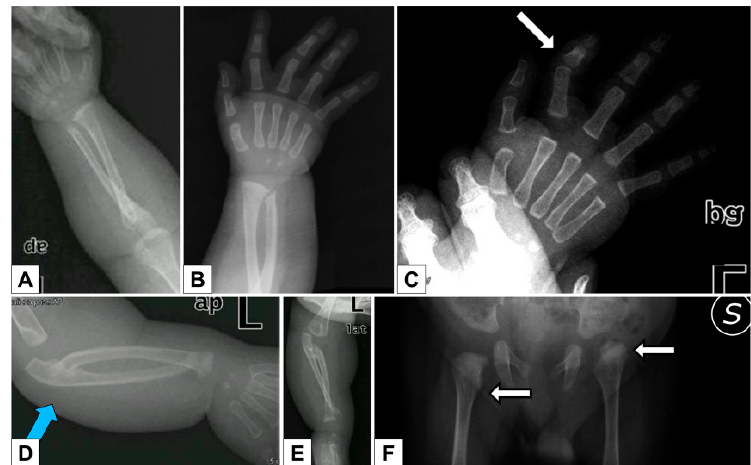
Figure 3. Patient 1 A – B , D – E ) Bilateral bowing of ulna and radius with dislocation / subluxation and radioulnar synostosis, metaphyseal widening of the radius; C ) bilateral short and dysmorphic 2nd finger middle phalanx, short first metacarpal; F ) hip dysplasia.